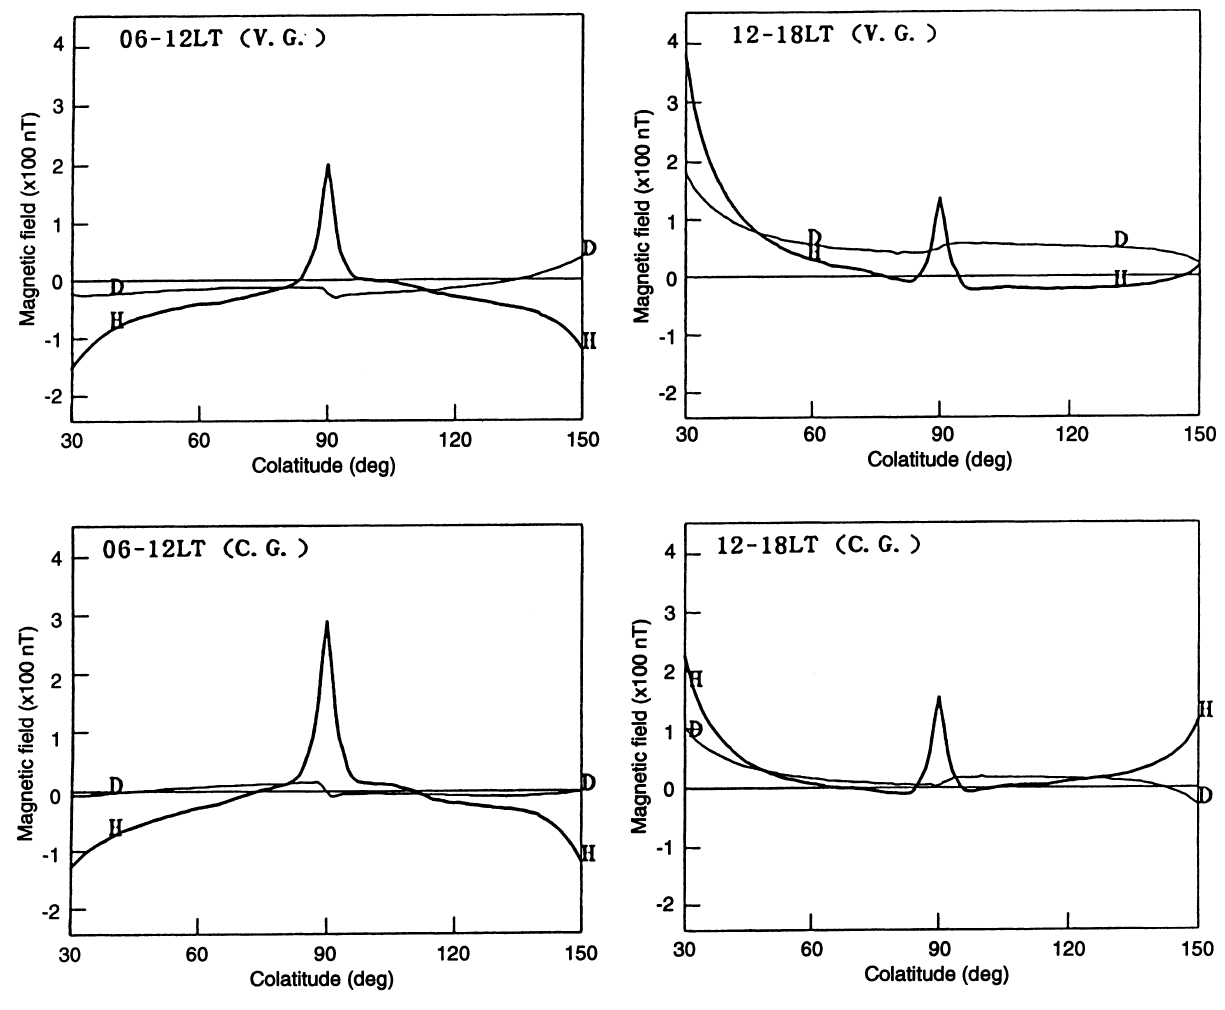
Fig. 12. Same as Fig. 11 for the latitude range from 60 (cid:176) to ) 60